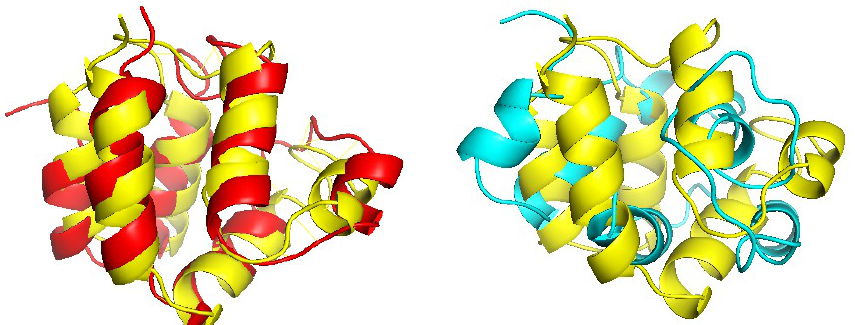
Figure 12. ( Left ) Structure model of d1a1w__(FADD death-effector domain) based on d1a1w__- d1dgna_ CRFalign alignment (red) overlapped with the experimental structure of d1a1w__ (yellow) (with TM score = 0.6477, rmsd = 2.318 ) and ( right ) that based on base model alignment (cyan) overlapped with the experimental structure (yellow) (with TM score = 0.3575, rmsd = 12.111).